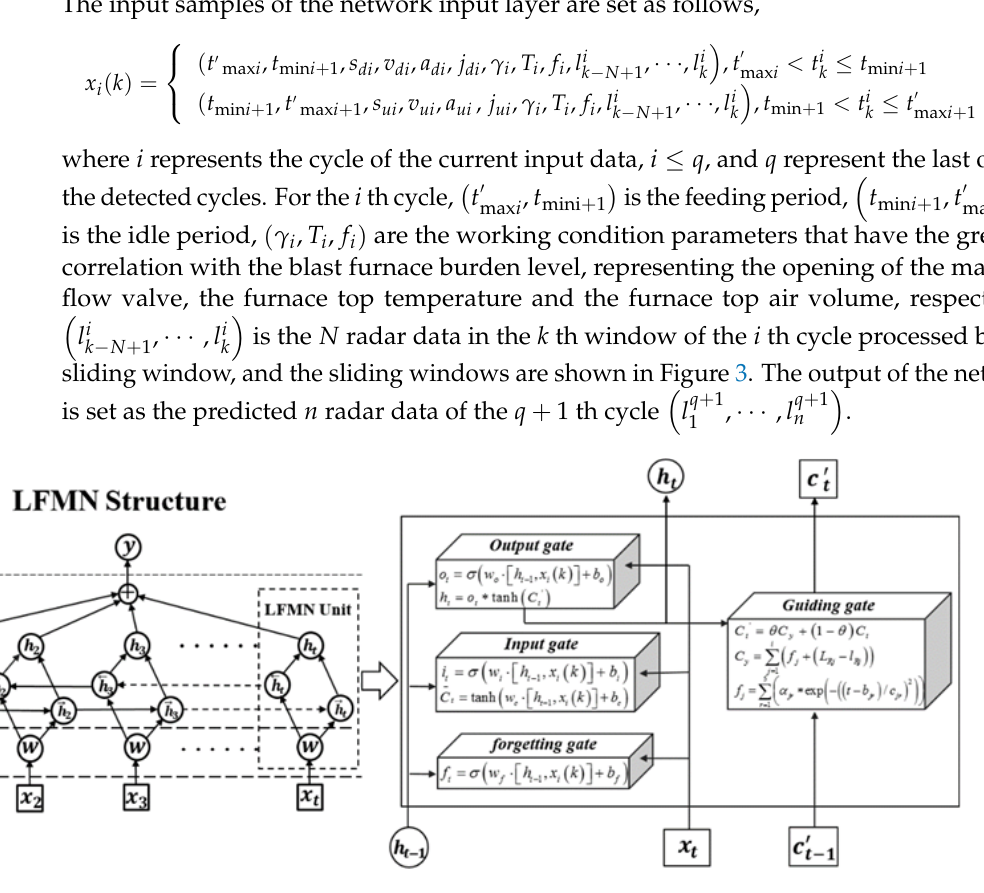
Figure 5. Structure of the long-term focus memory network. variables h and C , saving the short-term memory and long-term focus memory of the network. At time t , each memory unit has three inputs, which are the input sample of the time t , the short-term memory of the time 1 t − , and the long-term focus h − 1 t memory . The internal structure of each long-term focus memory unit is shown in C − 1 t the right figure of Figure 4, including four control gates, which are the input gate, forget- ting gate, guiding gate, and output gate. The long-term focus memory C is controlled by the input gate and the forgetting gate, which determines how many input states at the current time t are updated into the long-term focus memory. The forgetting gate determines how much of the long-term focus memory is retained for the current time t . Therefore, the long-term focus memory t C of the time t can be described as